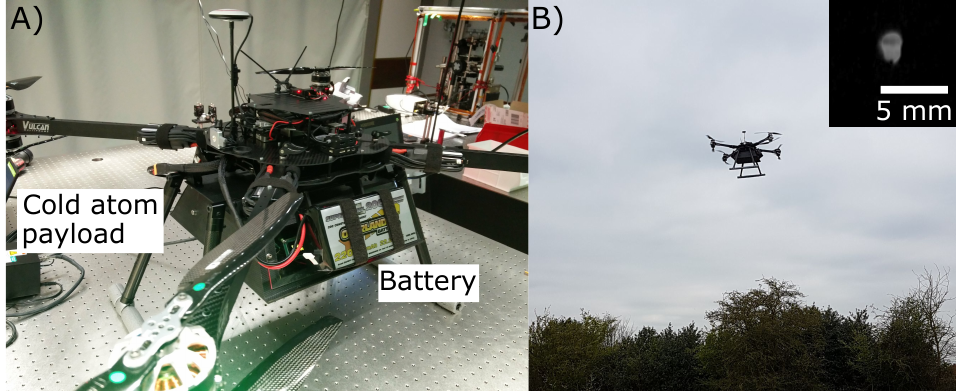
Figure 5. ( A ) The VulcanUAV Raven complete with (LiPo) batteries and compact MOT payload. ( B ) The MOT system in flight. The inset shows a photo of an atom cloud generated in the system during flight, after background